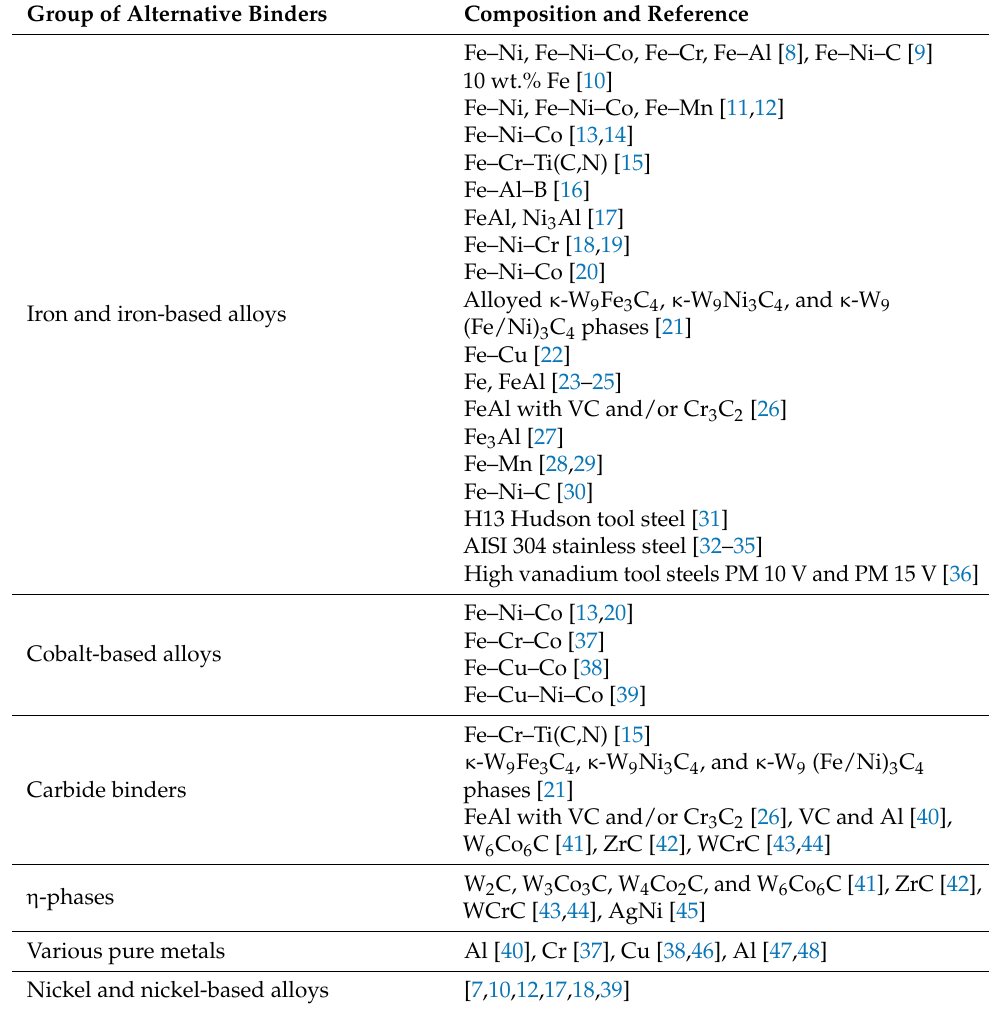
Table 1. Alternative binders for WC-based cemented